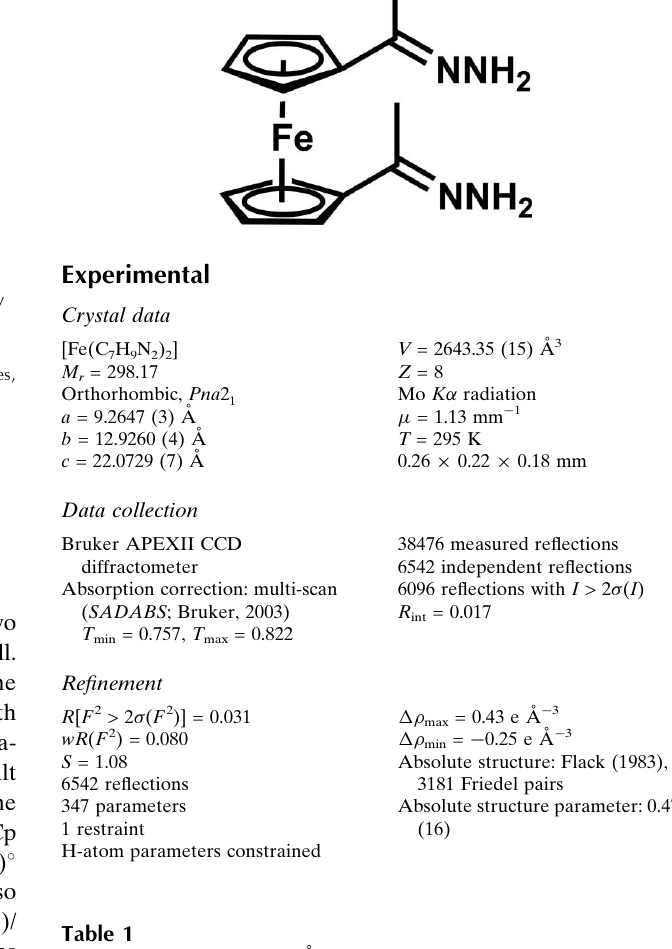
Hydrogen-bond geometry (A˚ , (cid:2)